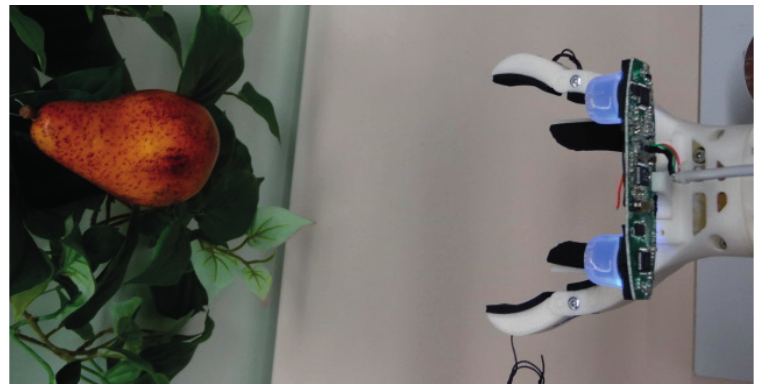
Figure 12. Example of a rough approach to a